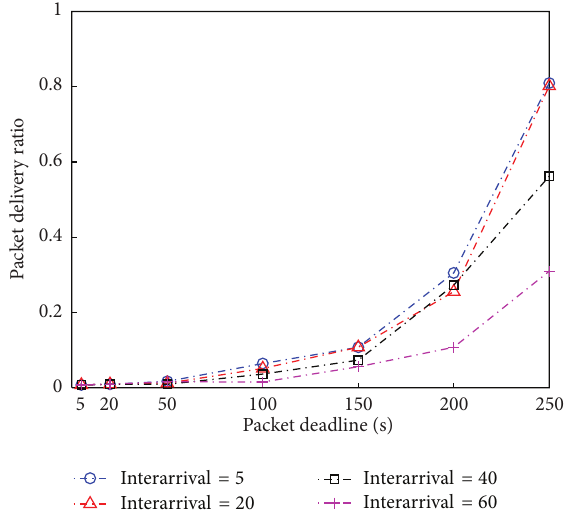
Figure 8: Contribution ratio for routing with mobile nodes with respect to packet deadline and mobile nodes’ interarrival